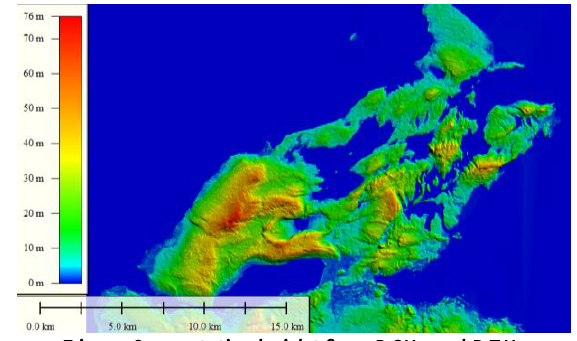
Figure 6. vegetation height from DSM and DTM